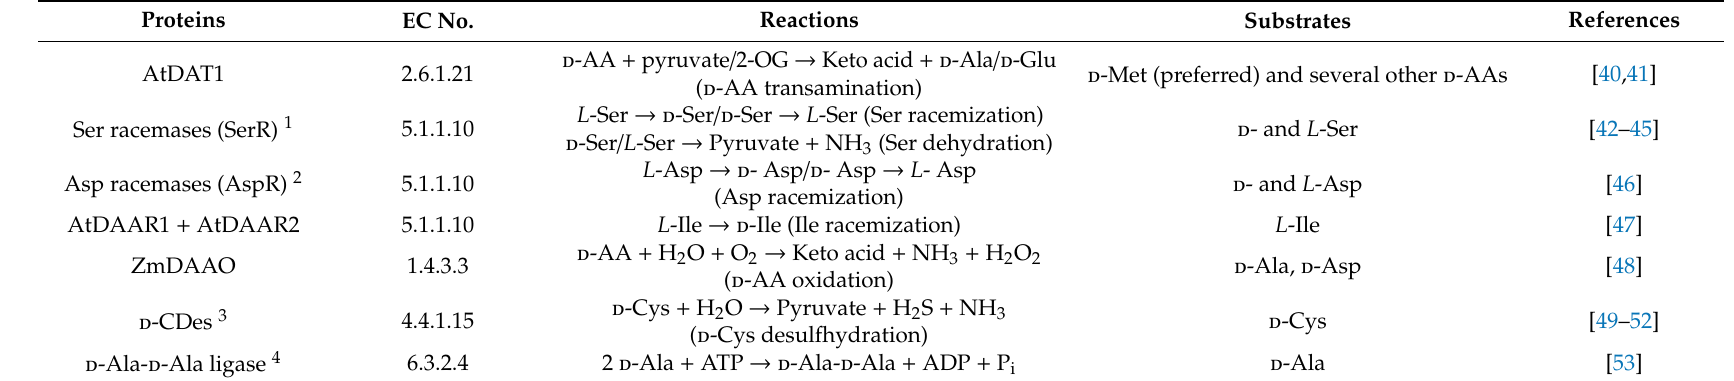
Table 1. Characterized d -AA utilizing and producing enzymes in